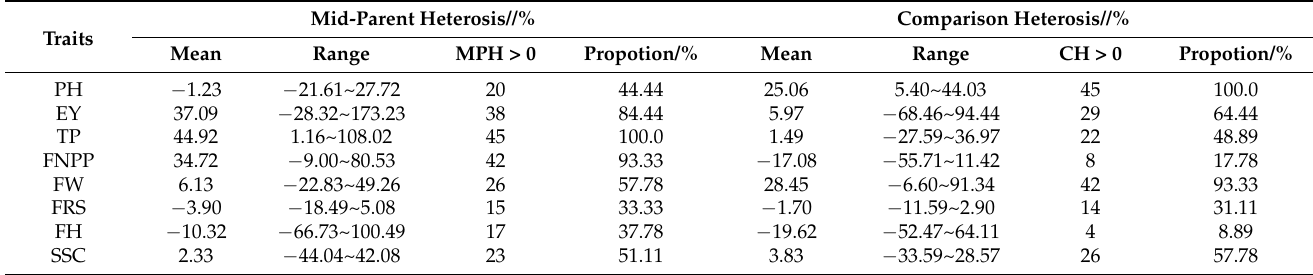
Table 6. Average heterosis of eight main agronomic traits in 45 cross combinations.